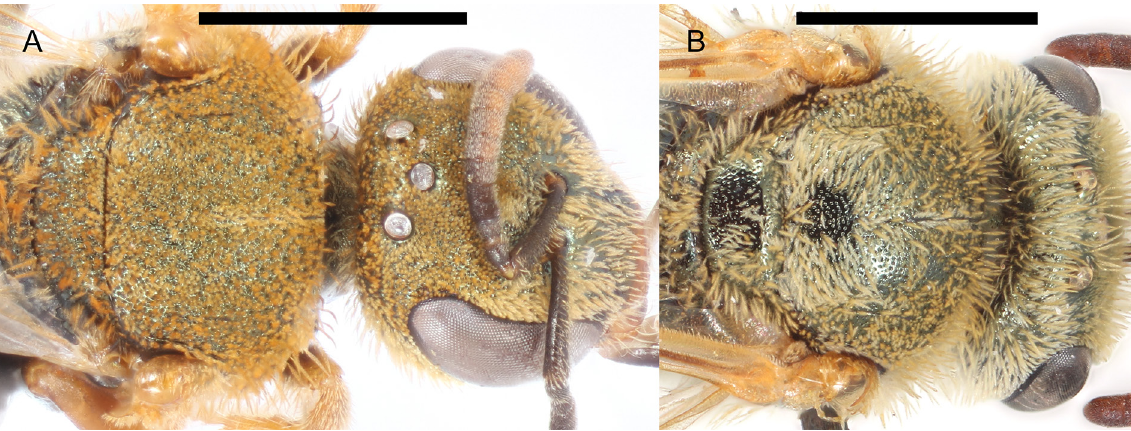
Fig. 92. Head and mesonotum. A . Lasioglossum ( D. ) vierecki (Crawford, 1904), ♀, with thickly plumose hair short and scale-like. B . L. ( D. ) cembrilacus sp. nov., ♀, with thickly plumose hair long. Scale bars: 1